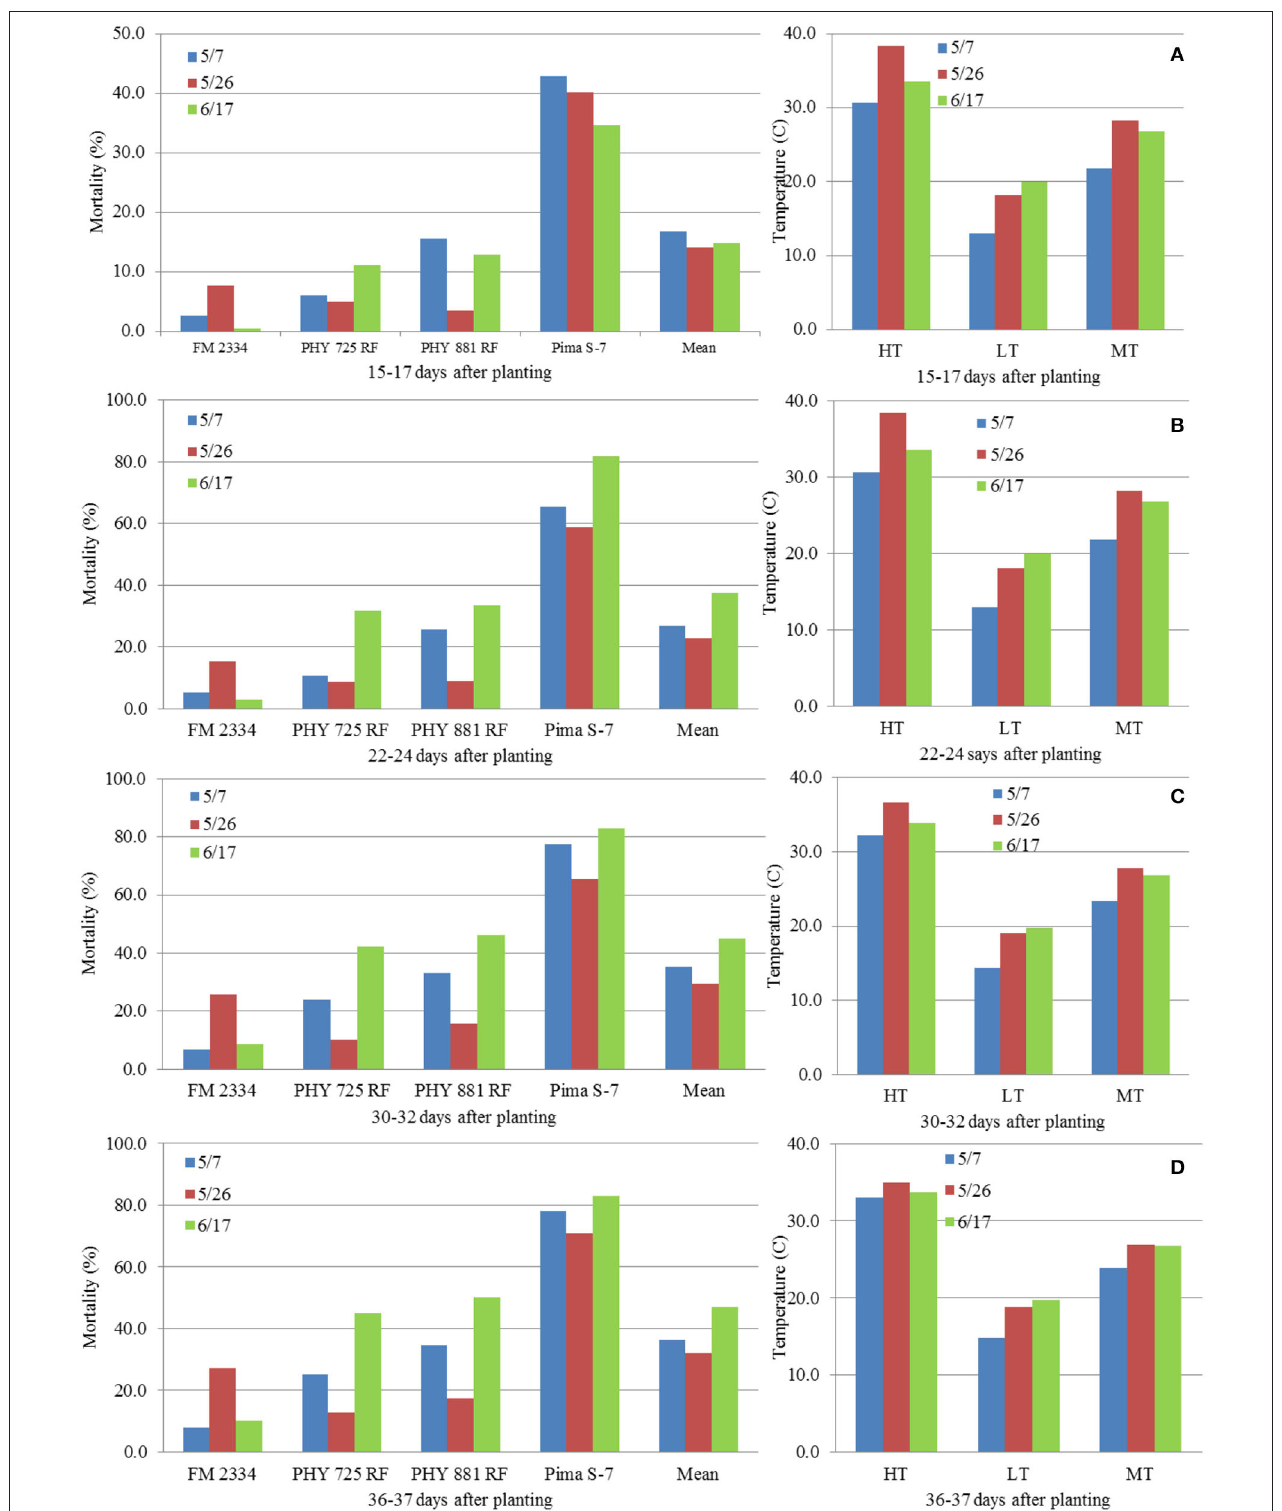
FIGURE 10 | Average mortality (%) in four cotton cultivars at different days [ (A) 15–17 DAP; (B) 22–24 DAP; (C) 30–32 DAP; (D) 36–37 DAP] after planting on May 5, May 26, and June 17, 2021, grown in pre-infested soil supplemented with artificial inoculation of Fusarium oxysporum f. sp. vasinfectum race 4, and average high (HT), low (LT), and mean (MT) temperatures from day of planting to the day of evaluation.